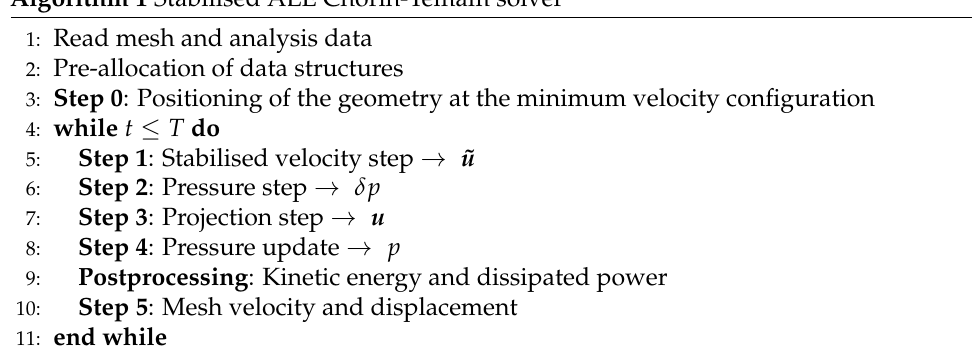
Algorithm 1 Stabilised ALE Chorin-Temam solver